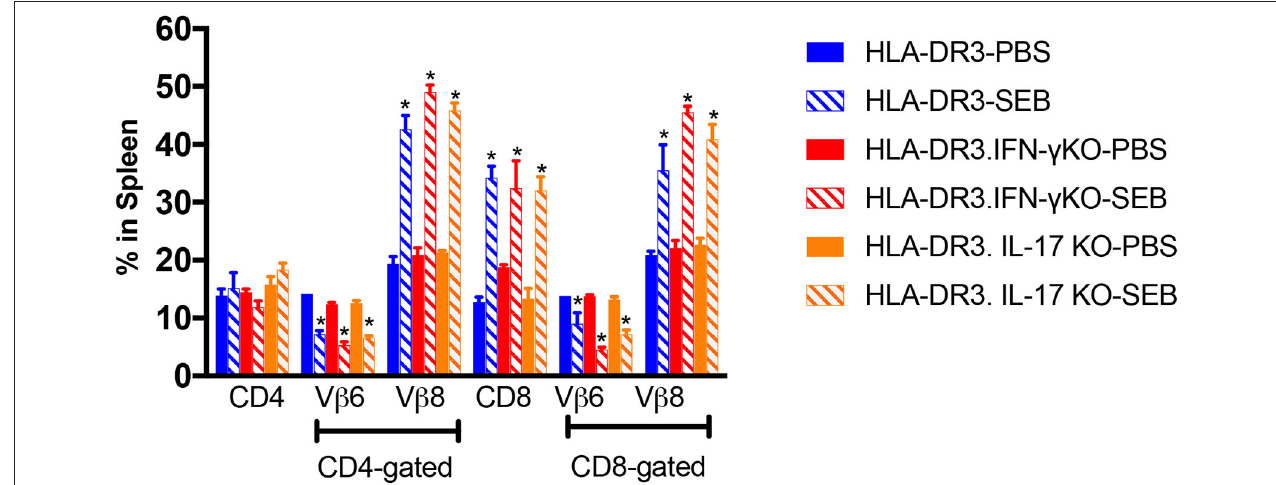
FIGURE 3 | SAg-induced peripheral T cell expansion in IFN- γ and IL-17A-deficient mice. HLA-DR3.WT, DR3.IFN- γ ◦ , and DR3.IL-17 ◦ were mice challenged with 50 µ g of SEB in 200 µ l of PBS by intraperitoneal route. Groups of mice were euthanized at 72h post-SEB challenge and spleens were collected. Mononuclear cell suspensions of splenocytes were stained with fluorochrome-conjugated antibodies. Percentage of CD4 + and CD8 + T cells expressing TCR V β 6 and V β 8 were determined by flow cytometry. Each bar represents mean ± SE from 3 to 5 mice. * p < 0.05 compared to respective PBS control